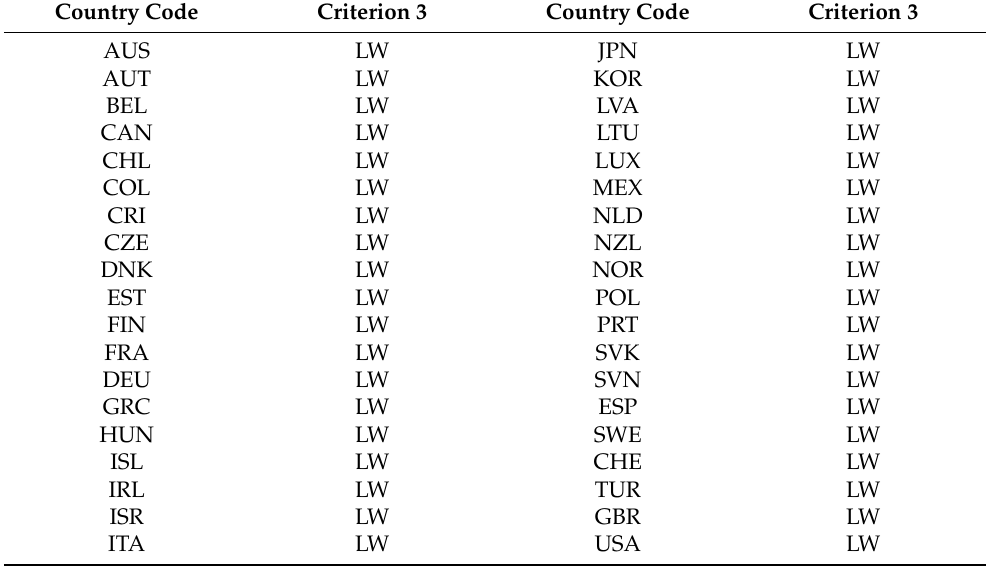
Table 15. Third Type-1 FIS Criterion